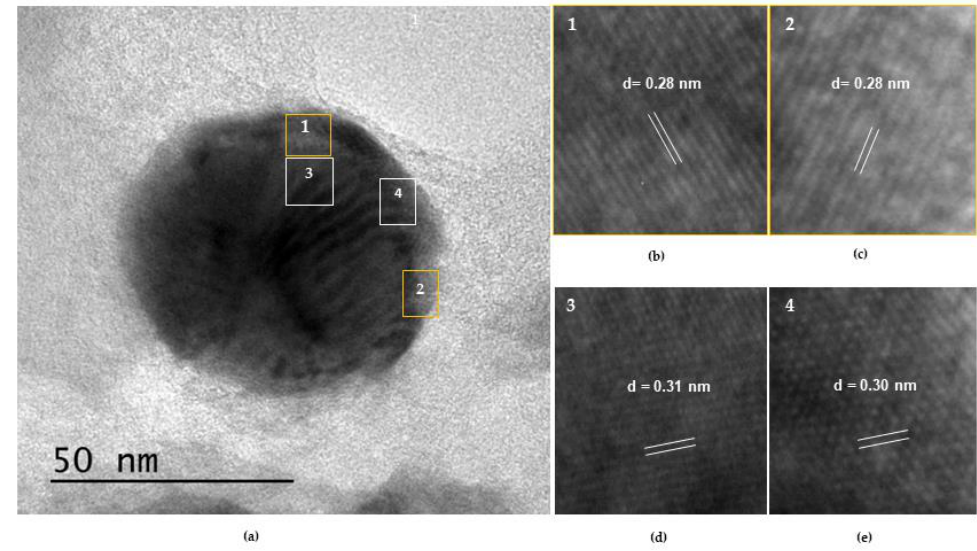
Figure 10. ( a ) HR-TEM micrograph of particle deposited on In 50 /C 50 electrode, measure after 2.5 h of electrolysis. ( b – e ) detail of lattice fringe spacings on spherical nanoparticle.